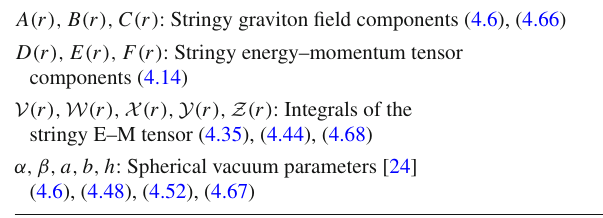
Table 1 Variables and parameters for the spherical solution to the D = 4 Einstein Double Field Equations. The final form of the solu- tion is summarized in (4.66), (4.67), and (4.68), where the constant parameters of the spherical vacuum geometry, { α,β, a , b , h } , are all identified as integrals of the stringy energy–momentum tensor, T AB , localized at the center A ( r ), B ( r ), C ( r ) : Stringy graviton field components (4.6), (4.66)